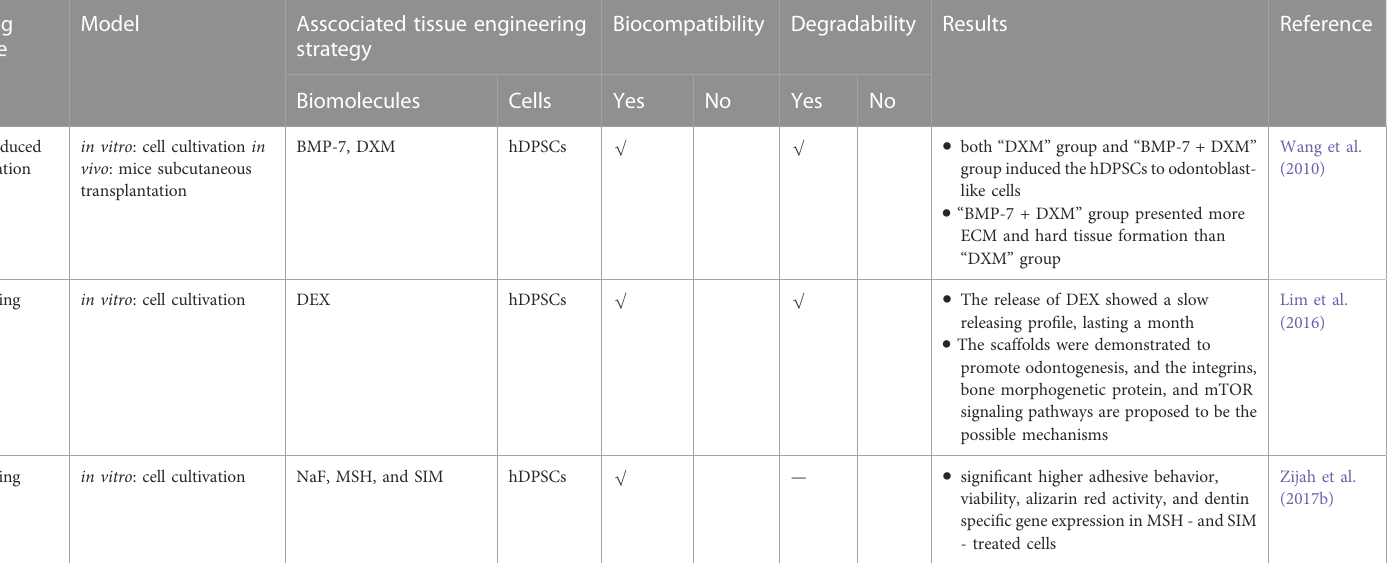
groupinducedthehDPSCstoodontoblast- like cells (cid:129) “ BMP-7 + DXM ” group presented more ECM and hard tissue formation than “ DXM ” group (cid:129) The scaffolds were demonstrated to promote odontogenesis, and the integrins, bone morphogenetic protein, and mTOR signaling pathways are proposed to be the possible mechanisms viability, alizarin red activity, and dentin speci fi c gene expression in MSH - and SIM - treated